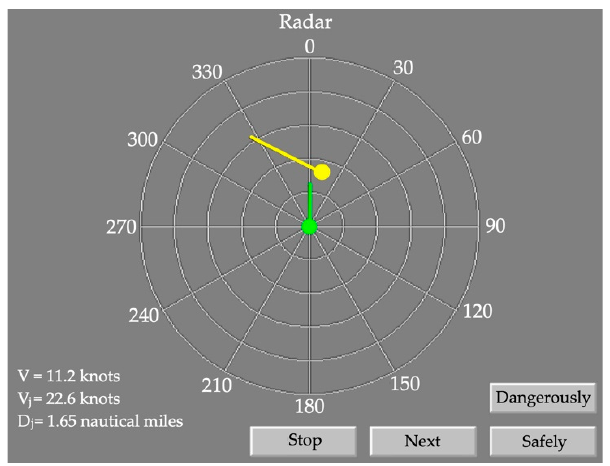
Figure 7. The navigation situation presented to the navigator as the teacher of the neural network.